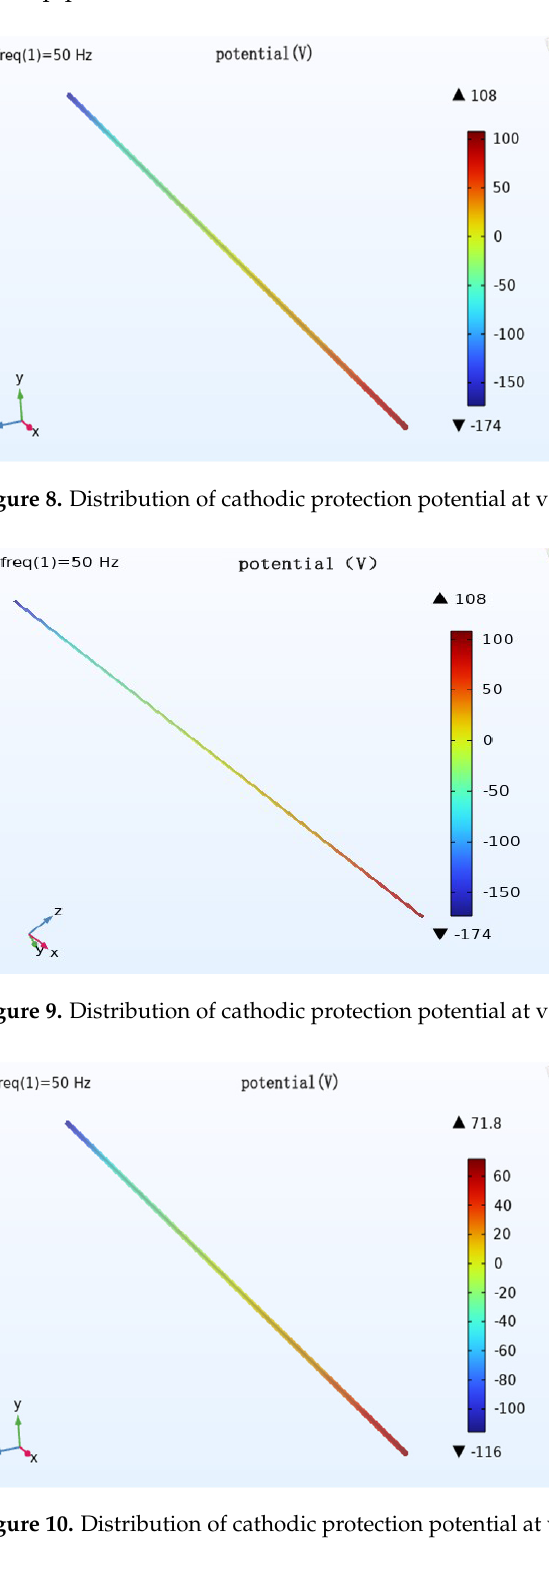
Figure 11. The influence law of transmission line voltage level on cathodic protection potential.